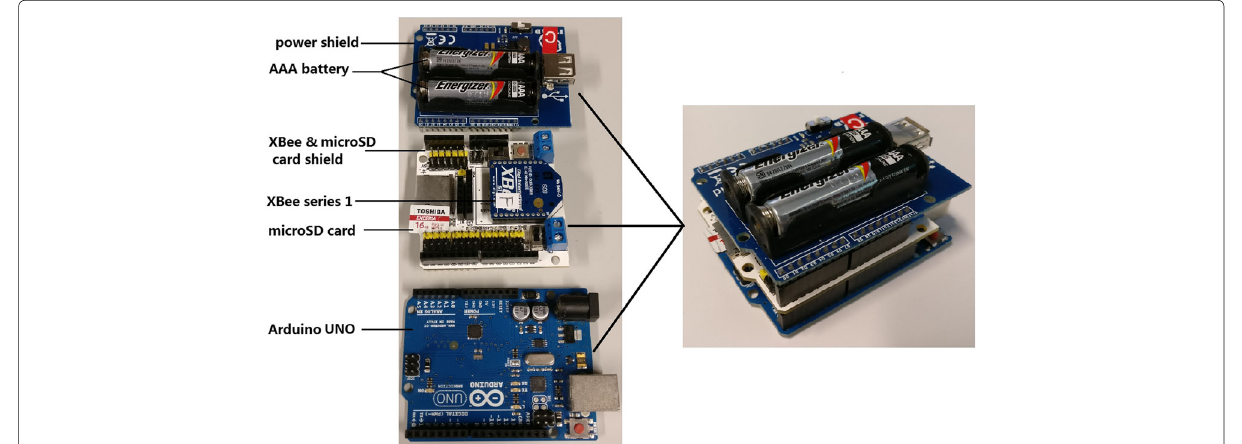
Fig. 2 Components of the portable